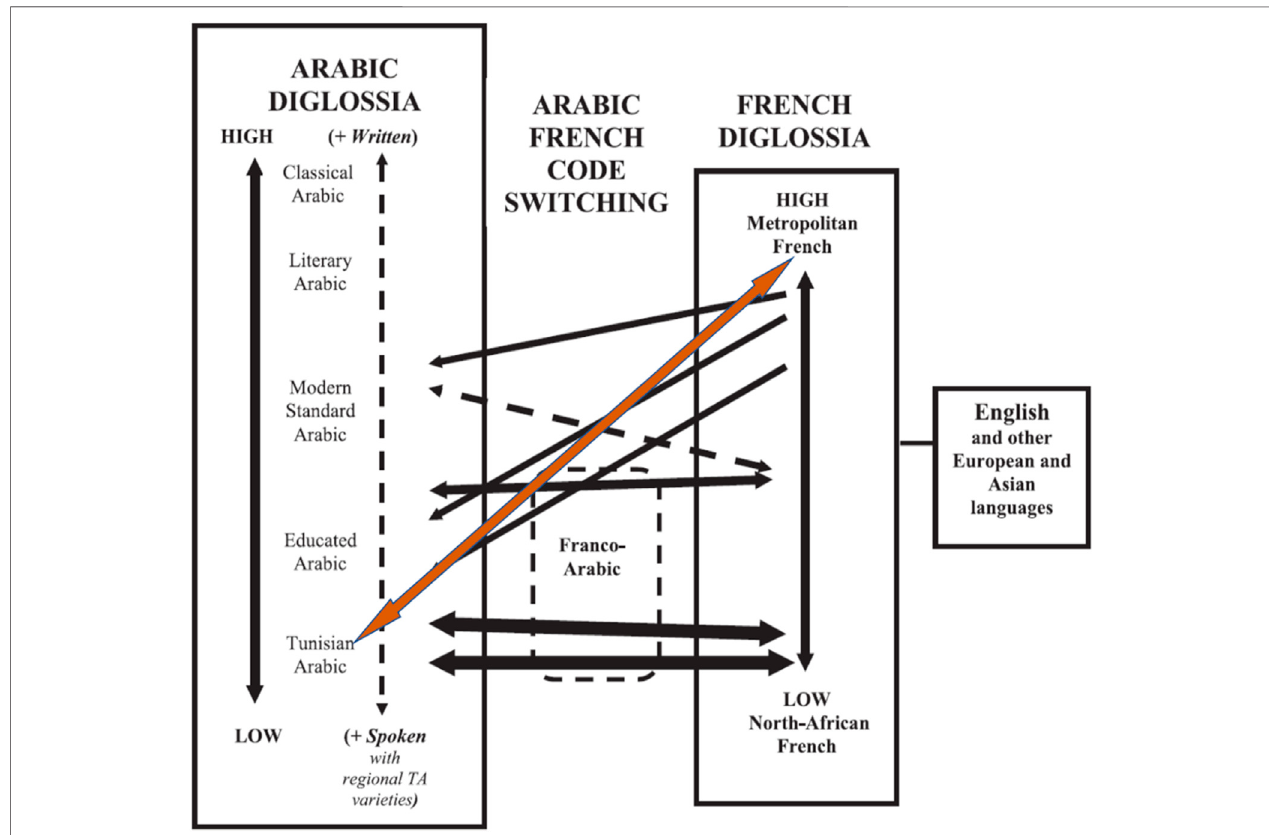
FIGURE 2 | Schematic representation of the current linguistic situation in Tunisia (Daoud